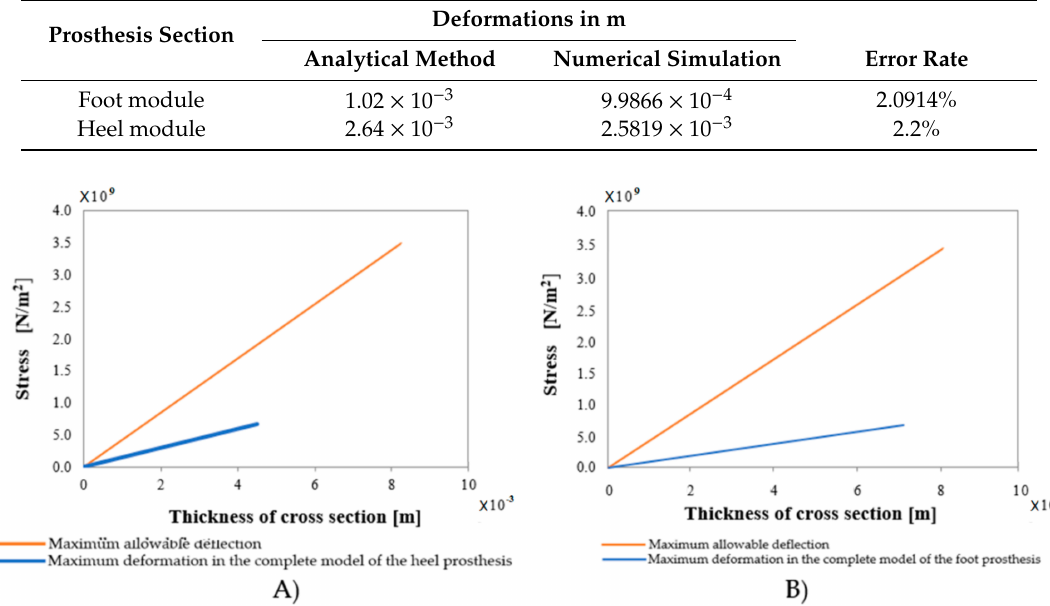
Table 5. Comparison of analytically and numerically computed deformations.